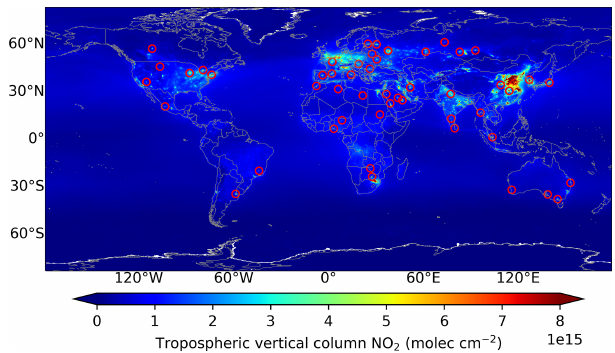
Figure 2. NO 2 tropospheric vertical column of the level-2 S5P TROPOMI product from March 2018 to February 2020. Red cir- cles mark NO x emission sources analyzed in this study. All ana- lyzed source regions are listed, with more details in the Appendix, Table